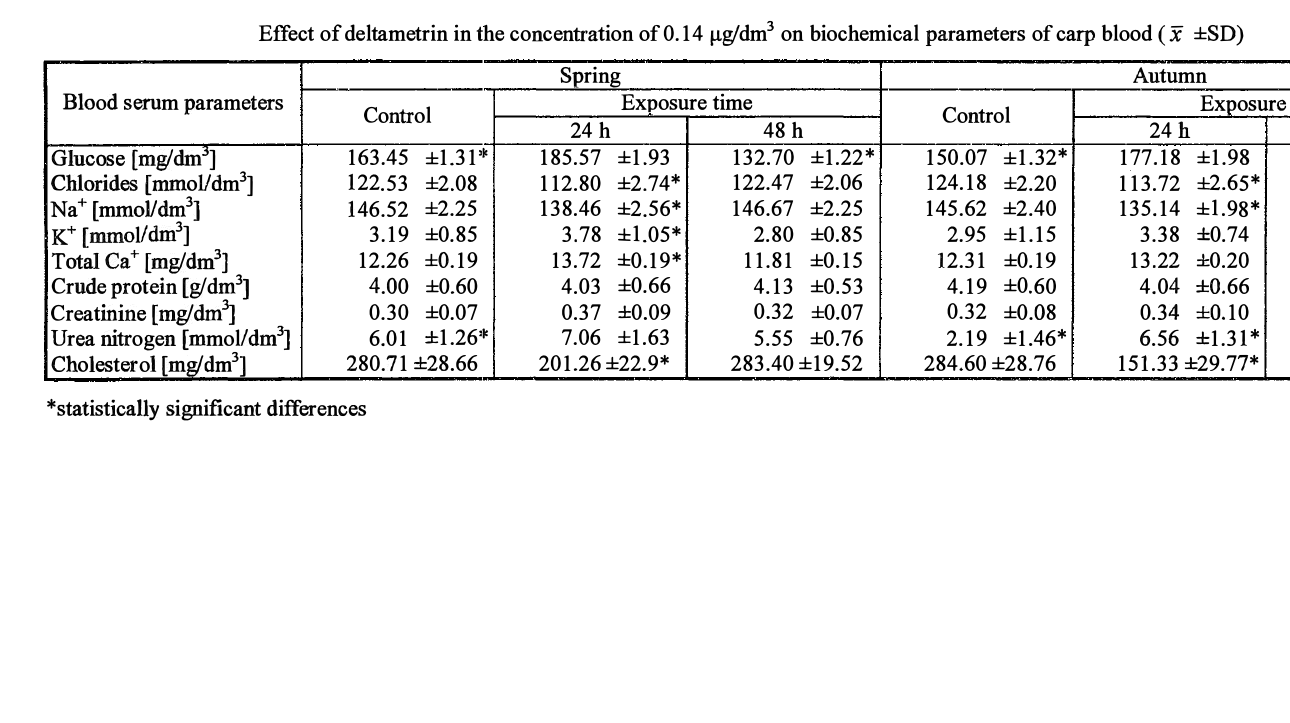
Effect of deltametrin in the concentration of0.14 µg/dm 3 on biochemical parameters of carp blood ( x